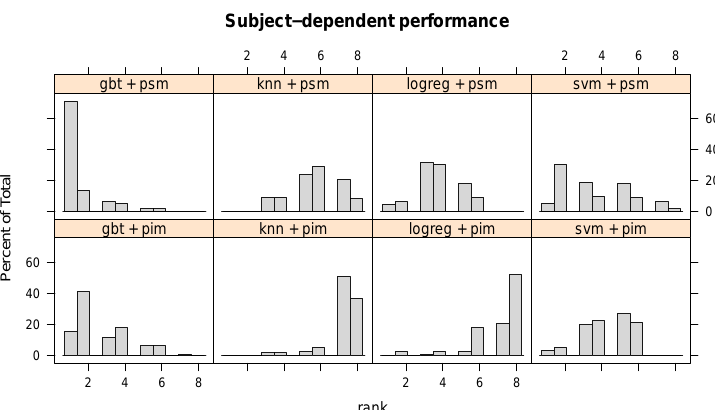
Figure 4. Distribution of the user-wise subject-dependent ranks of each learning algorithm + personalisation–generalisation approach. A person-specific gradient boosted ensemble of decision trees (GBT + PSM) outperforms the other methods for over 70% of users.